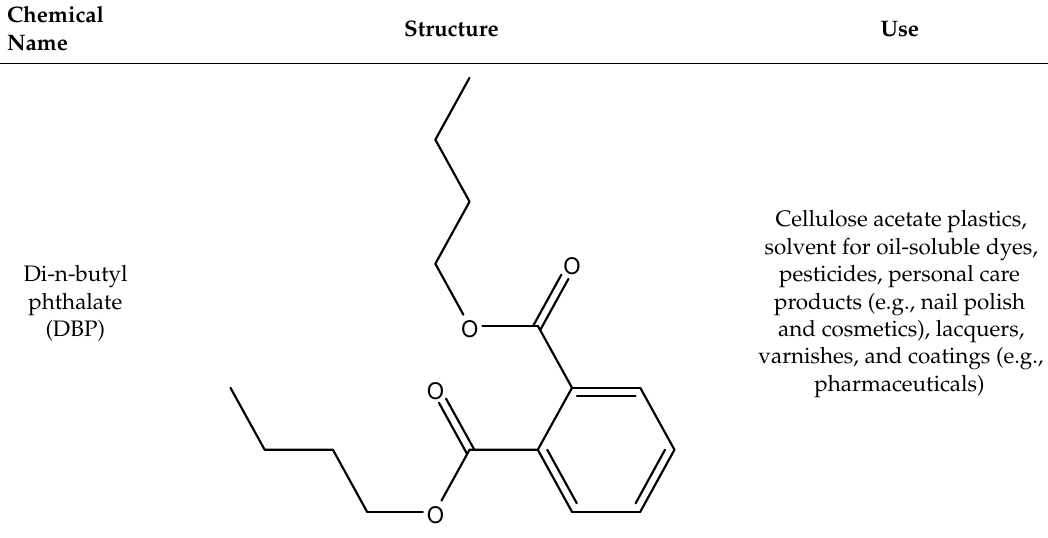
Table 2. List of abbreviations of the most common parent phthalates and their